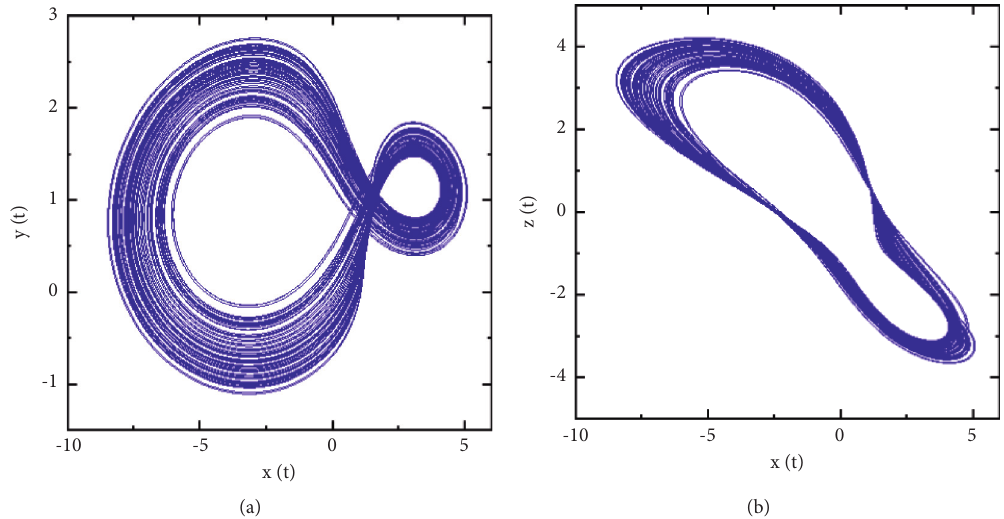
� 1 , q � 1 , and q � 0 . 89 projected onto (a) the x − y phase plane and 1 2 3